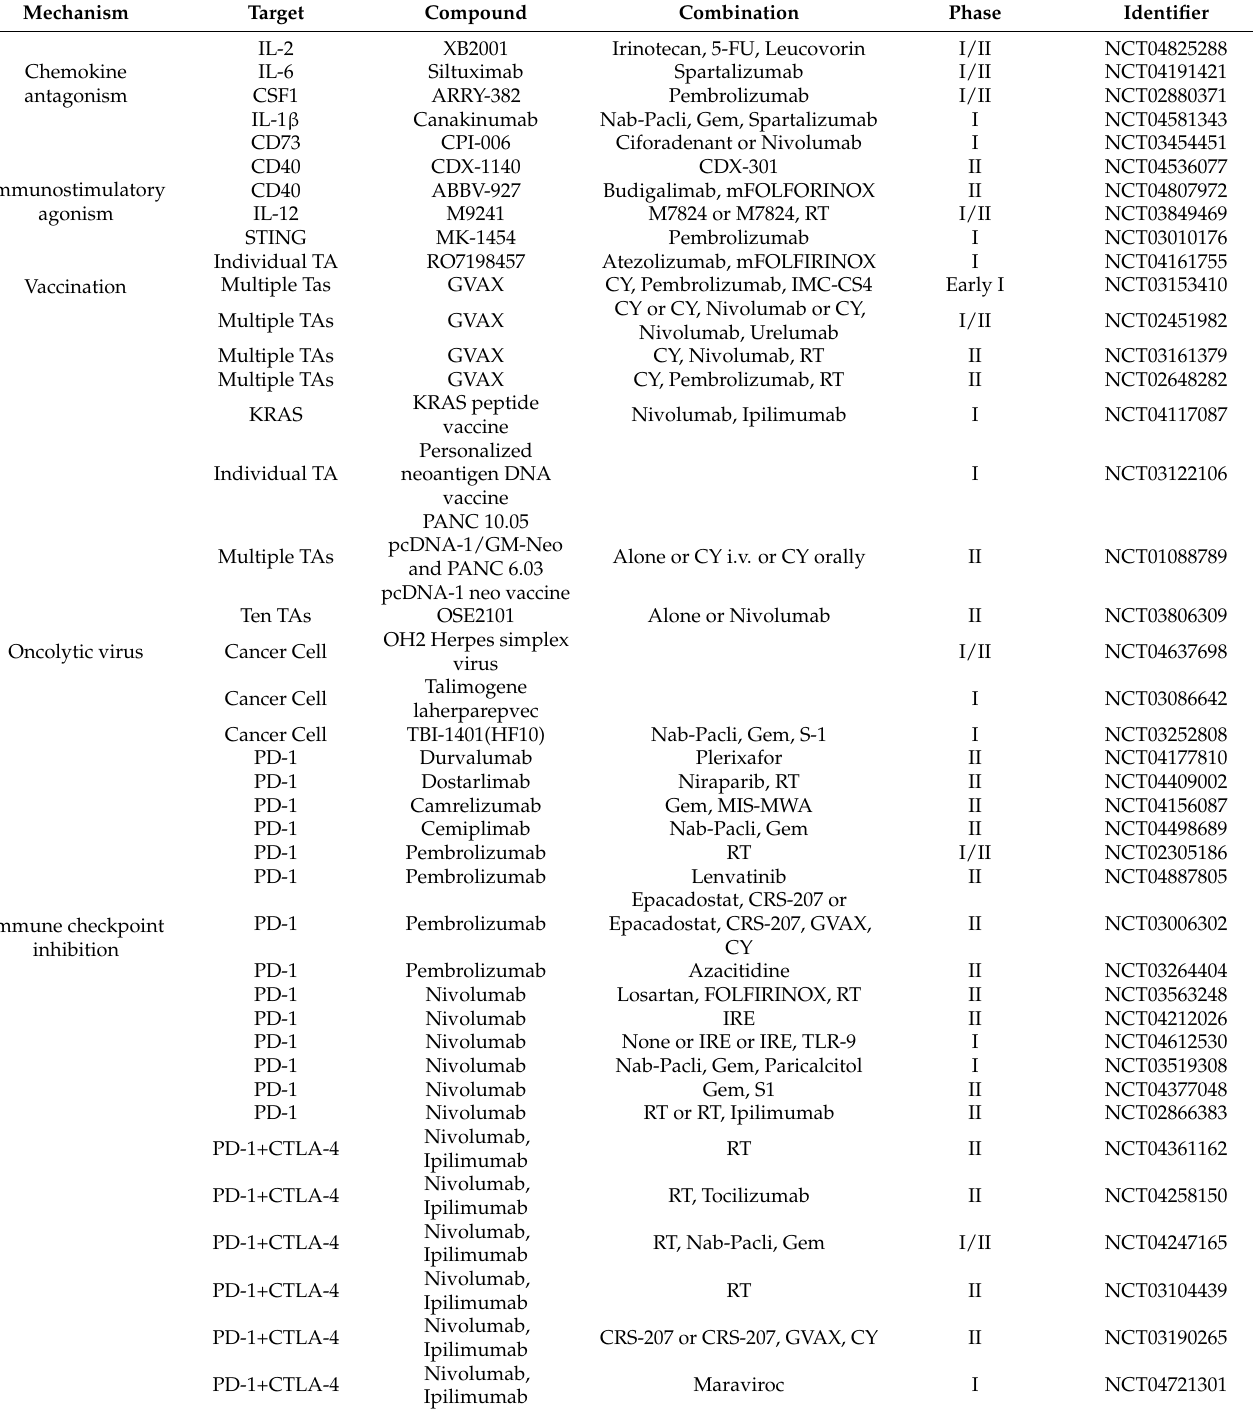
Table 1. Selected ongoing clinical trials investigating novel immunotherapeutic treatment strategies for PDAC. Abbrevi- ations: (CY) Cyclophosphamide; (5-FU) 5-Fluorouracil; (Gem) Gemcitabine; (ICOS) Inducible T-cell costimulator kinase inhibition; (IRE) Irreversible electroporation; (MIS-MWA) Minimally invasive surgical microwave ablation; (Nab-Pacli) Nab-Paclitaxel; (RT) Radiotherapy; (STING) Stimulator of interferon